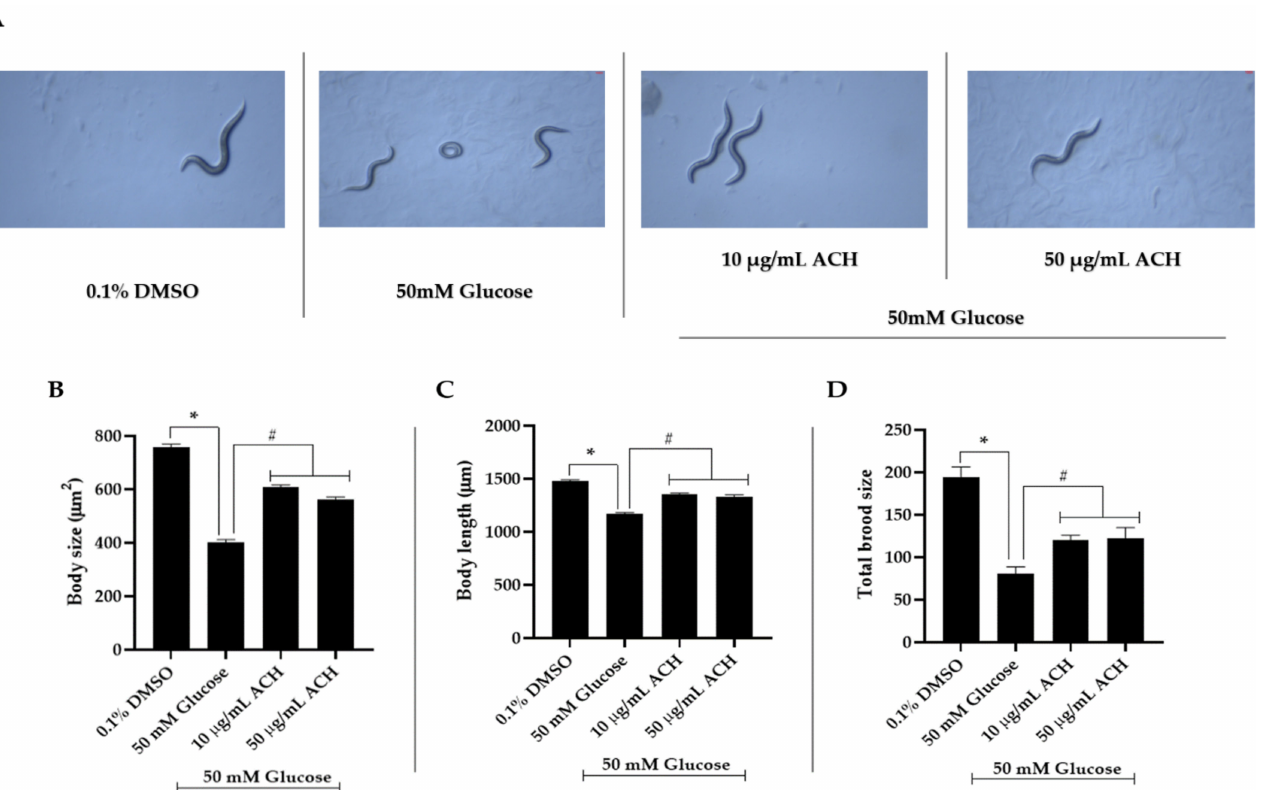
Figure 4. ACH extracts attenuated the high glucose-induced reduction of body length and size and brood size. Bright-field microscope images of C. elegans were taken using a 10x objective, and representative images are shown ( A ). The body size and length were measured from at least 20 adult day 1 worms. The number of eggs hatching were counted. The mean ± SEM values of body size ( B ), body length ( C ) and brood size ( D ) are shown, * p < 0.05 vs. control; # p < 0.05 vs. 50 mM glucose-fed